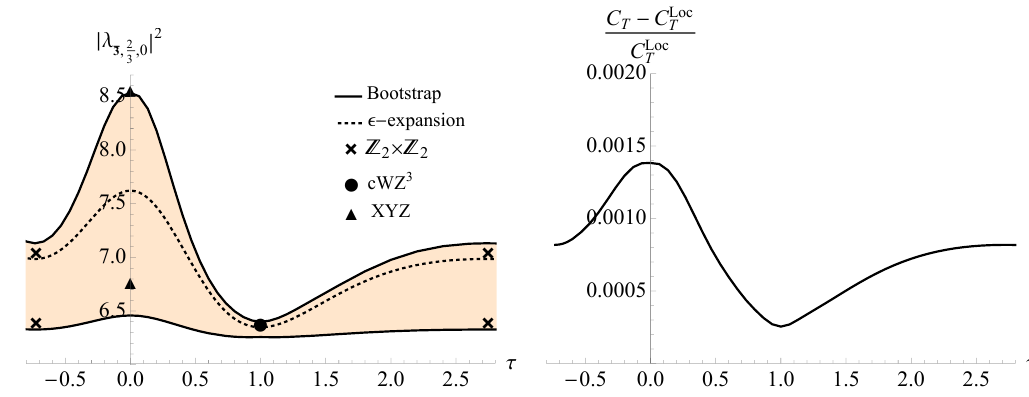
Figure 6 . Left: upper and lower bounds on the chiral bilinear OPE coe(cid:14)cient squared (cid:21) 2 p p real 1 (cid:0) 3 (cid:20) (cid:28) (cid:20) 1 + 3. The cross, circle, and triangle denote the results from the previous (cid:6)p sections for the enhanced symmetry points (cid:28) = 1 3 ; 1 ; 0 for the Z 2 (cid:2) Z 2 , cWZ 3 , and XYZ models respectively. The dotted lines show the 2-loop 4 (cid:0) " -expansion results. Right: upper bounds on C T p p for real 1 (cid:0) 3 (cid:20) (cid:28) (cid:20) 1 + 3 compared to the (cid:28) -independent localization value in (2.30). Both plots were computed using the G o Z 2 (cid:13)avor symmetry crossing equations with (cid:3) = 19.